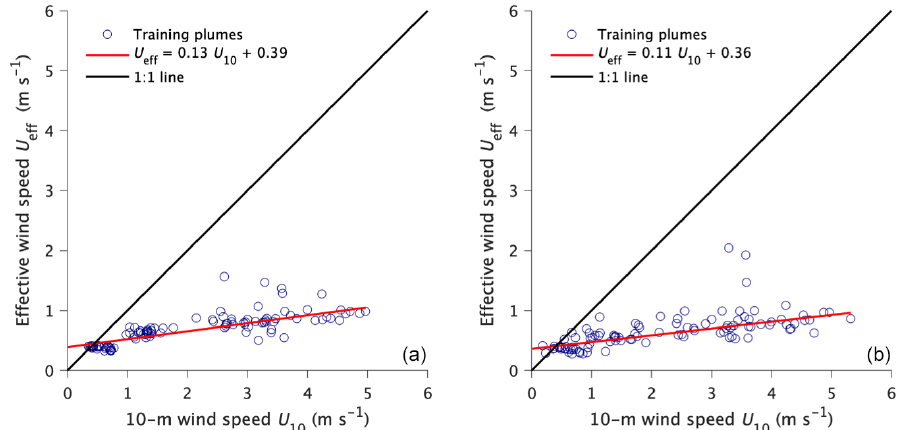
Figure 3. Scatter plots relating the effective and local 10m wind speeds ( U eff vs. U 10 ) in the IME method, characterized with WRF-LES training plumes. Panel (a) shows the fit obtained for σ = 120ppb and Q ∈ [ 100 , 3000 ] kgh − 1 . Panel (b) shows the fit for σ = 370ppb and Q ∈ [ 100 , 500 ] kgh − 1 . Black and red lines show, respectively, the 1:1 fit and the linear regression